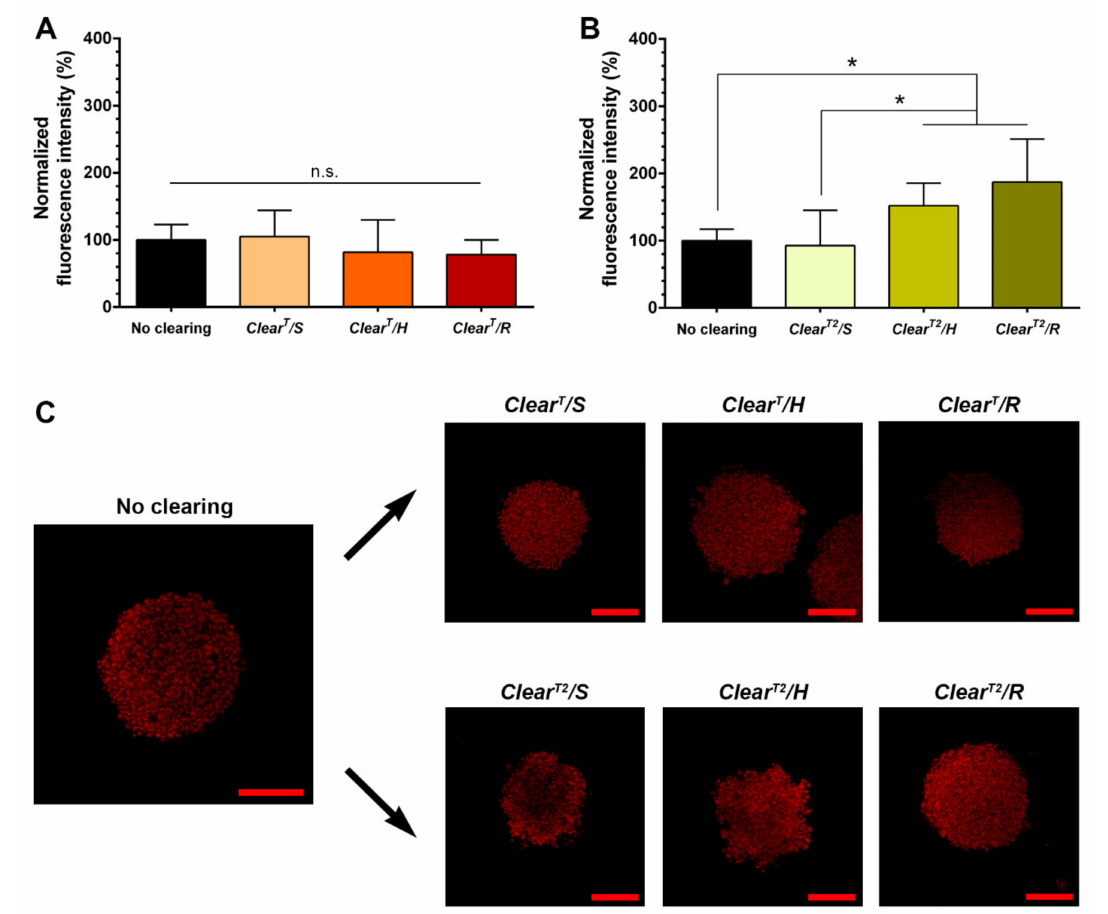
Figure 3. Influence of the immersion conditions used to perform the Clear T and Clear T2 on the PI fluorescence intensity in HFIB spheroids. Fluorescence intensity of PI-stained spheroids after clearing with Clear T ( A ) and Clear T2 ( B ) methods under static, horizontal agitation, and rotatory agitation, normalized to the average of the non-cleared spheroids fluorescence intensity. Maximum intensity projections CLSM images with a thickness of 100 µ m of non-cleared spheroids and spheroids cleared by Clear T and Clear T2 methods under static, horizontal agitation, and rotatory agitation ( C ). Scale bars correspond to 200 µ m; n = 9, * p < 0.05,